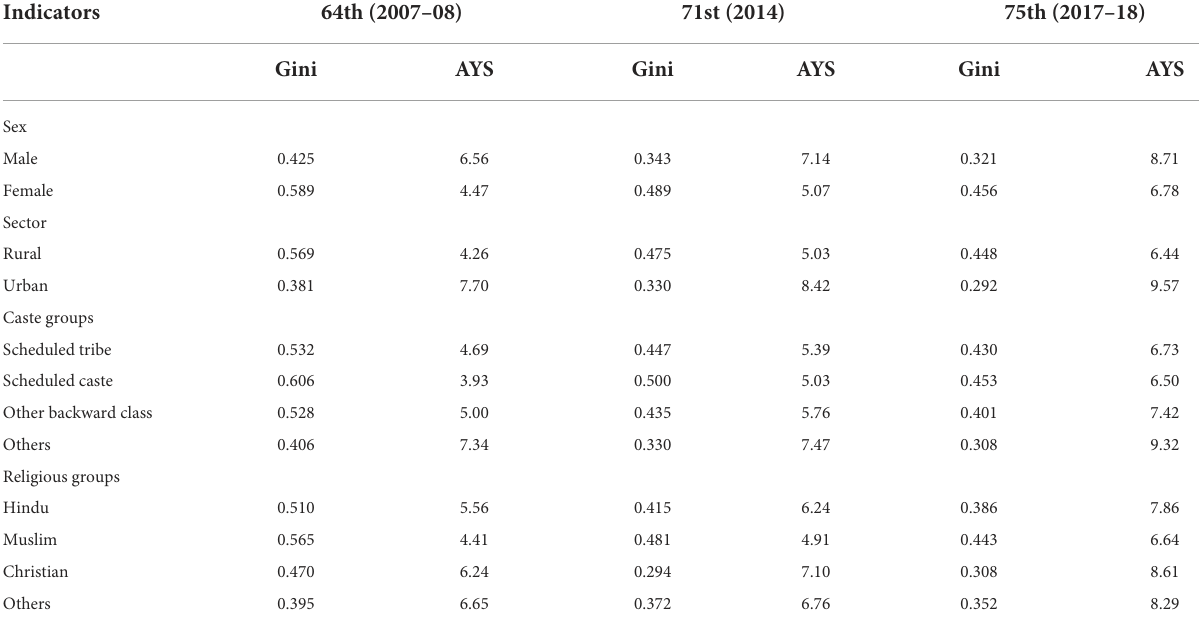
TABLE 5 Gini coefficient and average years of schooling (AYS) by social indicators.